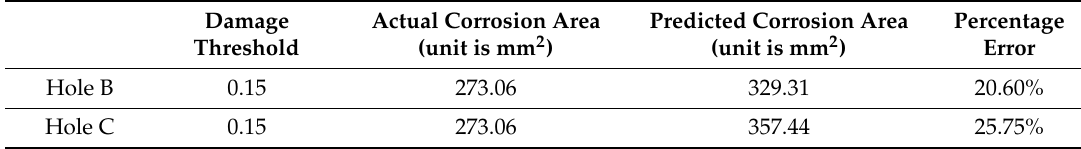
Figure 14. ( a ) The area of real two-hole corrosion and ( b ) the area of predicted two-hole corrosion. Table 4. Damage Simulation and Prediction